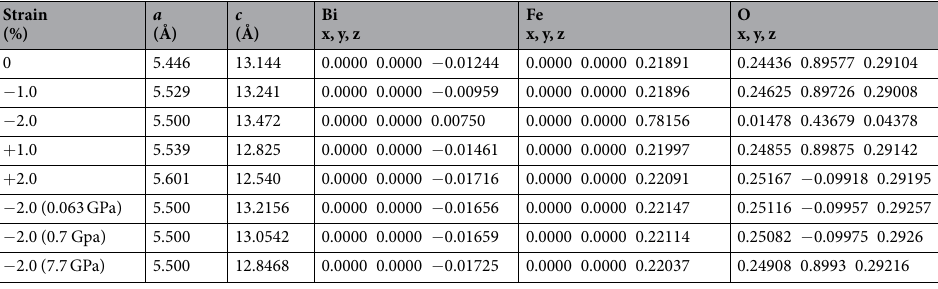
Table 1. The strain, lattice parameters, ion positions, and compressive pressure as obtained from first principle calculations using density functional theory. The ion positions obtained are used for calculating the off- centre displacement in a cell. The results simulate the experimentally observed nonmonotonic particle-size- dependence of off-centre displacement in nanoscale BiFeO 3